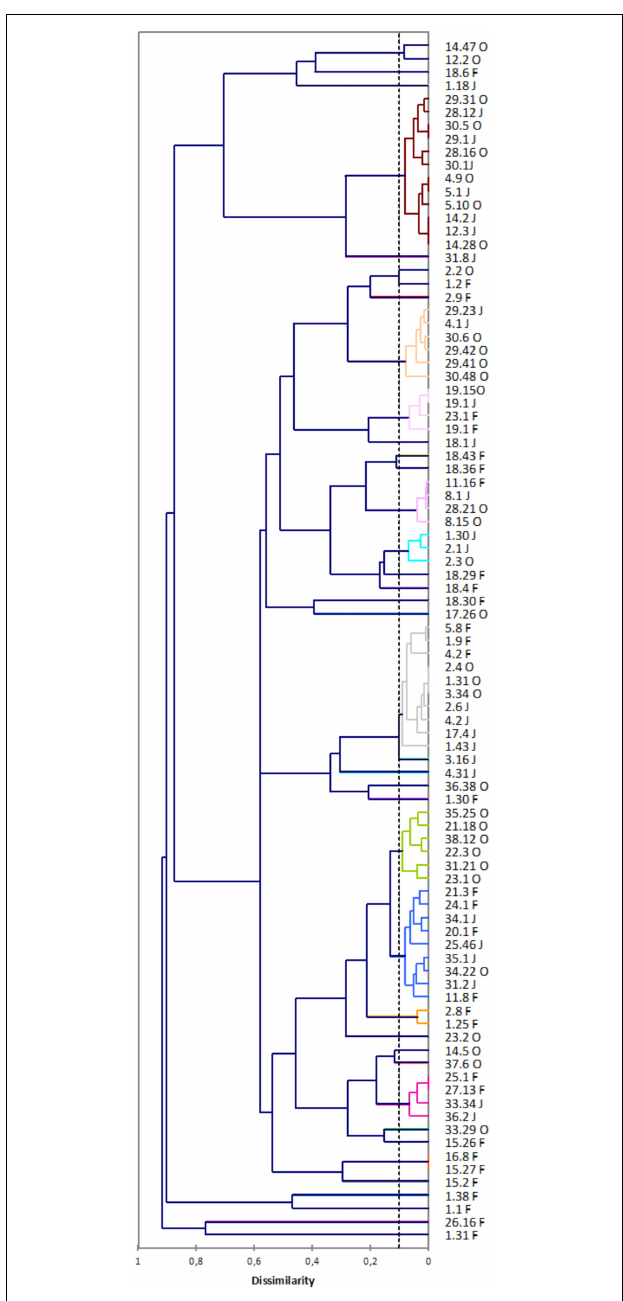
FIGURE 3 | Dendrogram derived from UPGMA cluster analysis of inter delta using dissimilarity